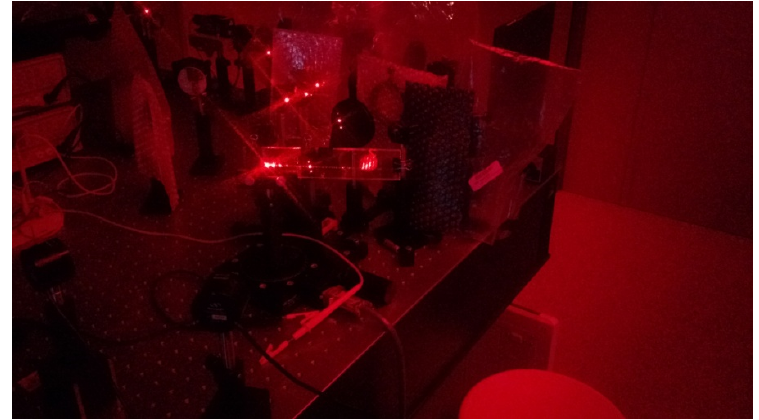
Figure 6. Holographic waveguide under red light illumination.